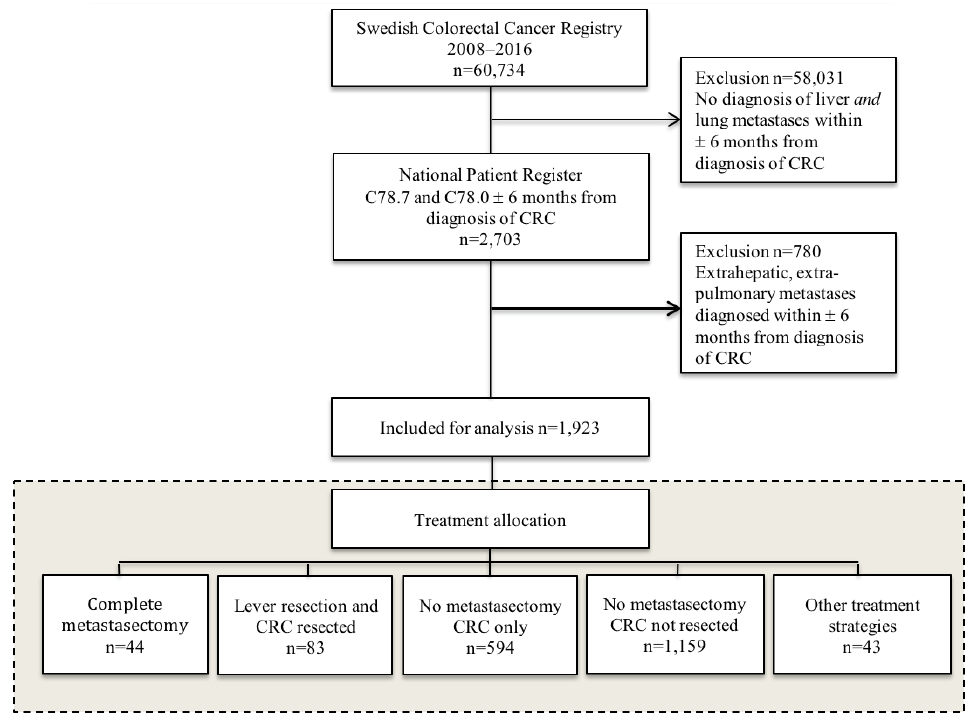
Figure 1. Flowchart of the identification of all patients diagnosed with liver and lung metastases within six months from diagnosis of colorectal cancer between 2008–2016 in Sweden. CRC, colorectal cancer. Table 1. Patient and tumor characteristics in 1923 patients with synchronously diagnosed liver and lung metastases from colorectal cancer.